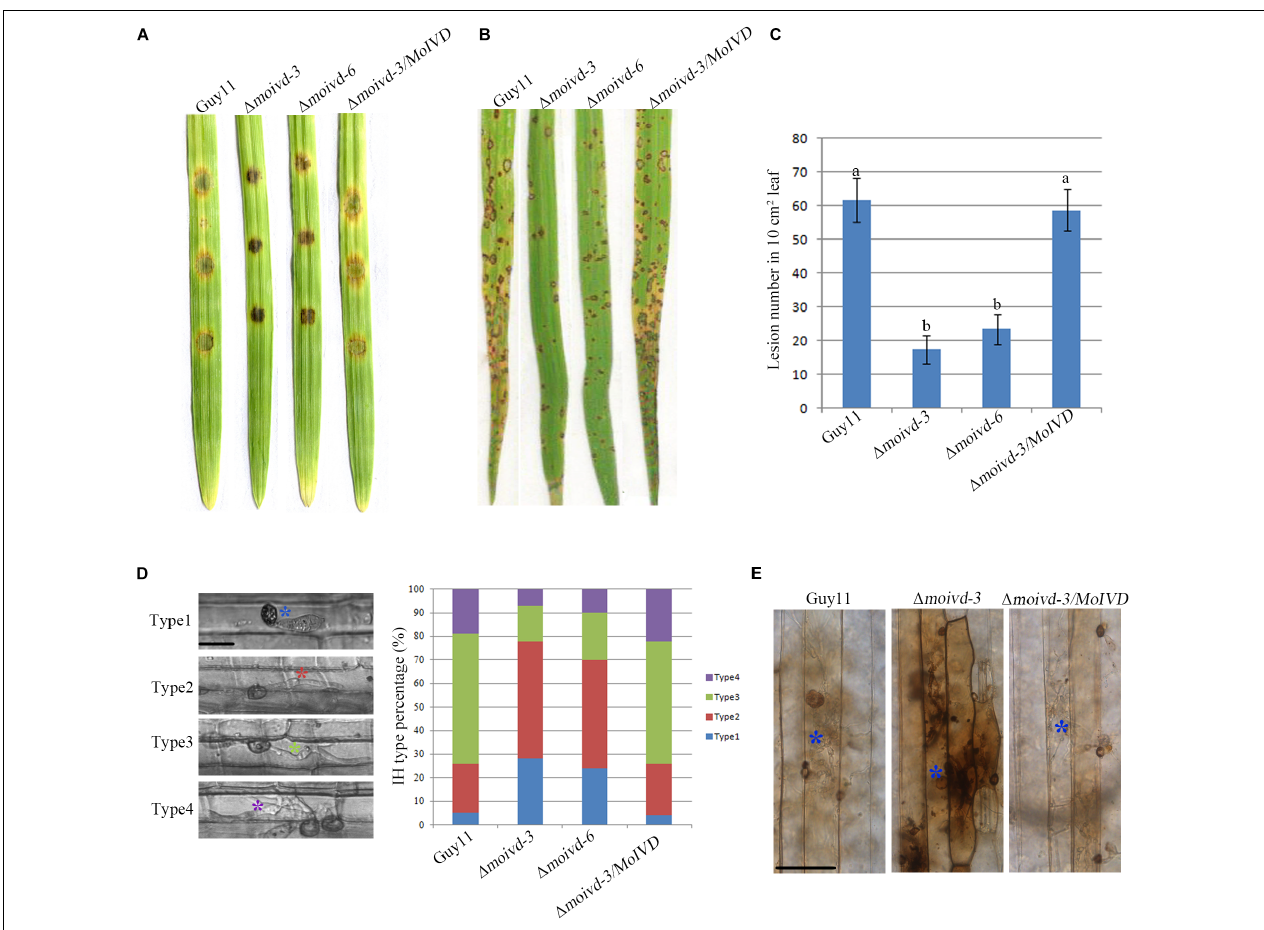
FIGURE 4 | The pathogenicity assay of the (cid:49) moivd mutants. (A) Pathogenicity test of the (cid:49) moivd mutants on excised barley leaves. The conidium was set at a concentration of 1 × 10 5 spores/ml. (B) Spray inoculation assay of the (cid:49) moivd mutants on rice seedlings. The conidium was set at a concentration of 5 × 10 4 spores/ml. (C) Quantitative analysis of lesion numbers in 10 cm 2 leaf size. The data was calculated from three independent replicates. The same lowercases ‘a’ or ‘b’ on the sample bar indicate no significant differences between samples. The different lowercases indicate significant differences ( P < 0.05; t test). (D) Statistic analysis of the invasive hyphae growth rate. The hyphae are divided into four types according to the growth speed. Type 1 indicates no penetration; Type 2 indicates penetration with a small peg; Type 3 represents the invasive hyphae in extension. Type 4 indicates the hyphae crossing the second host cell. Different color asterisk indicates the different hyphae type. Bar = 10 µ m. (E) DAB staining of barley leaves infected by (cid:49) moivd-3 after inoculation for 24 h. The asterisk indicates the stained infected host cell by DAB (1 mg/ml). Bar = 50 µ